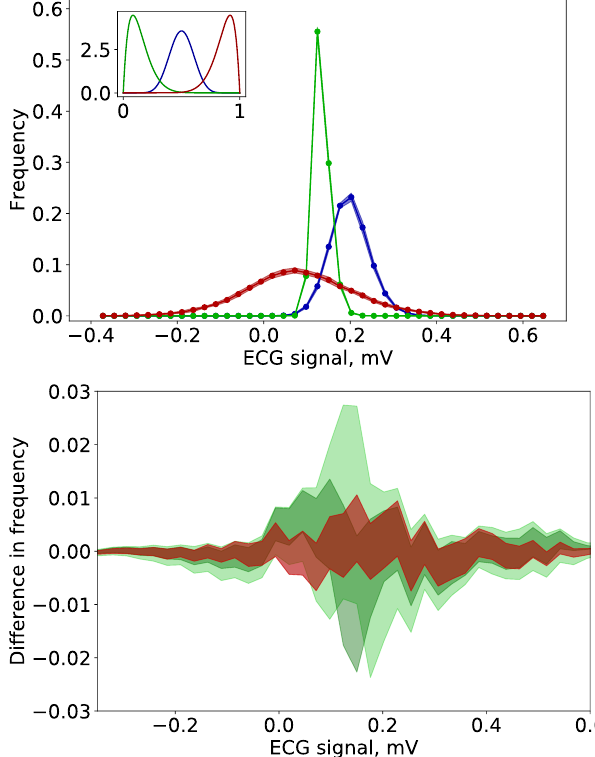
Figure 7. Comparison of distributions of ECG values at a fixed time point ( t = 55 ms) in the signal of lead V1 (cf. Figure 2 in the upper right panel). ( Top ): The statistical properties of the Monte–Carlo sampled ground truth dataset (black, 10,000 samples) agree very well with the spectrum of values of the PCE approximations. A good PCE model ( p = 6 and N S = 9900, depicted in red) and contrasting, a very basic one ( p = 2 and N S = 100, in green) agree very well in the depicted 2 σ bands, respectively. ( Middle ): The surrogate model allows for a quick re-sampling for a more versatile UQ. As an example, all input parameters were sampled from either of the three Beta distributions p β shown in the inlay (the color coding matches the obtained output distributions), cf. text for more details. ( Bottom ): The deviations from the histogram of the ground truth data (GTD, cf. black line in the top panel) for three different PCE surrogate models. The mean and 2 σ band are depicted for p = 2 and N S = 100 in light green, p = 2 and N S = 9900 in dark green and p = 6 and N S = 9900 in red. With an